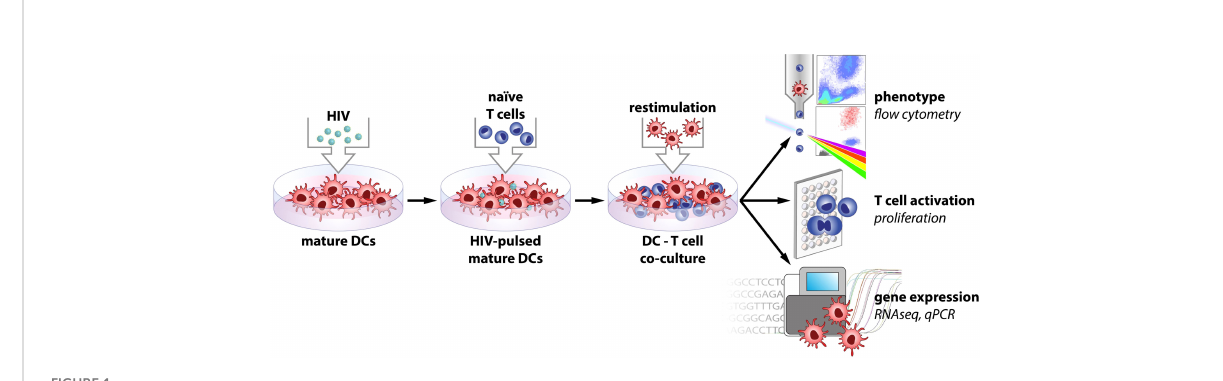
FIGURE 1 Model of experimental